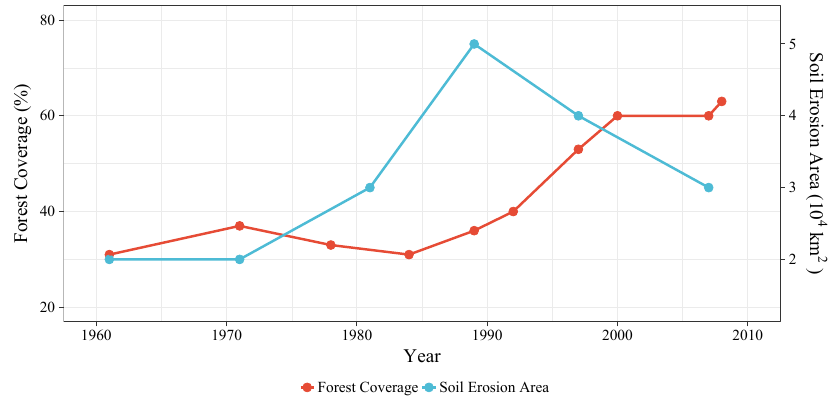
Figure 8. Changes of forest coverage and soil erosion area in PYLB from 1960 to